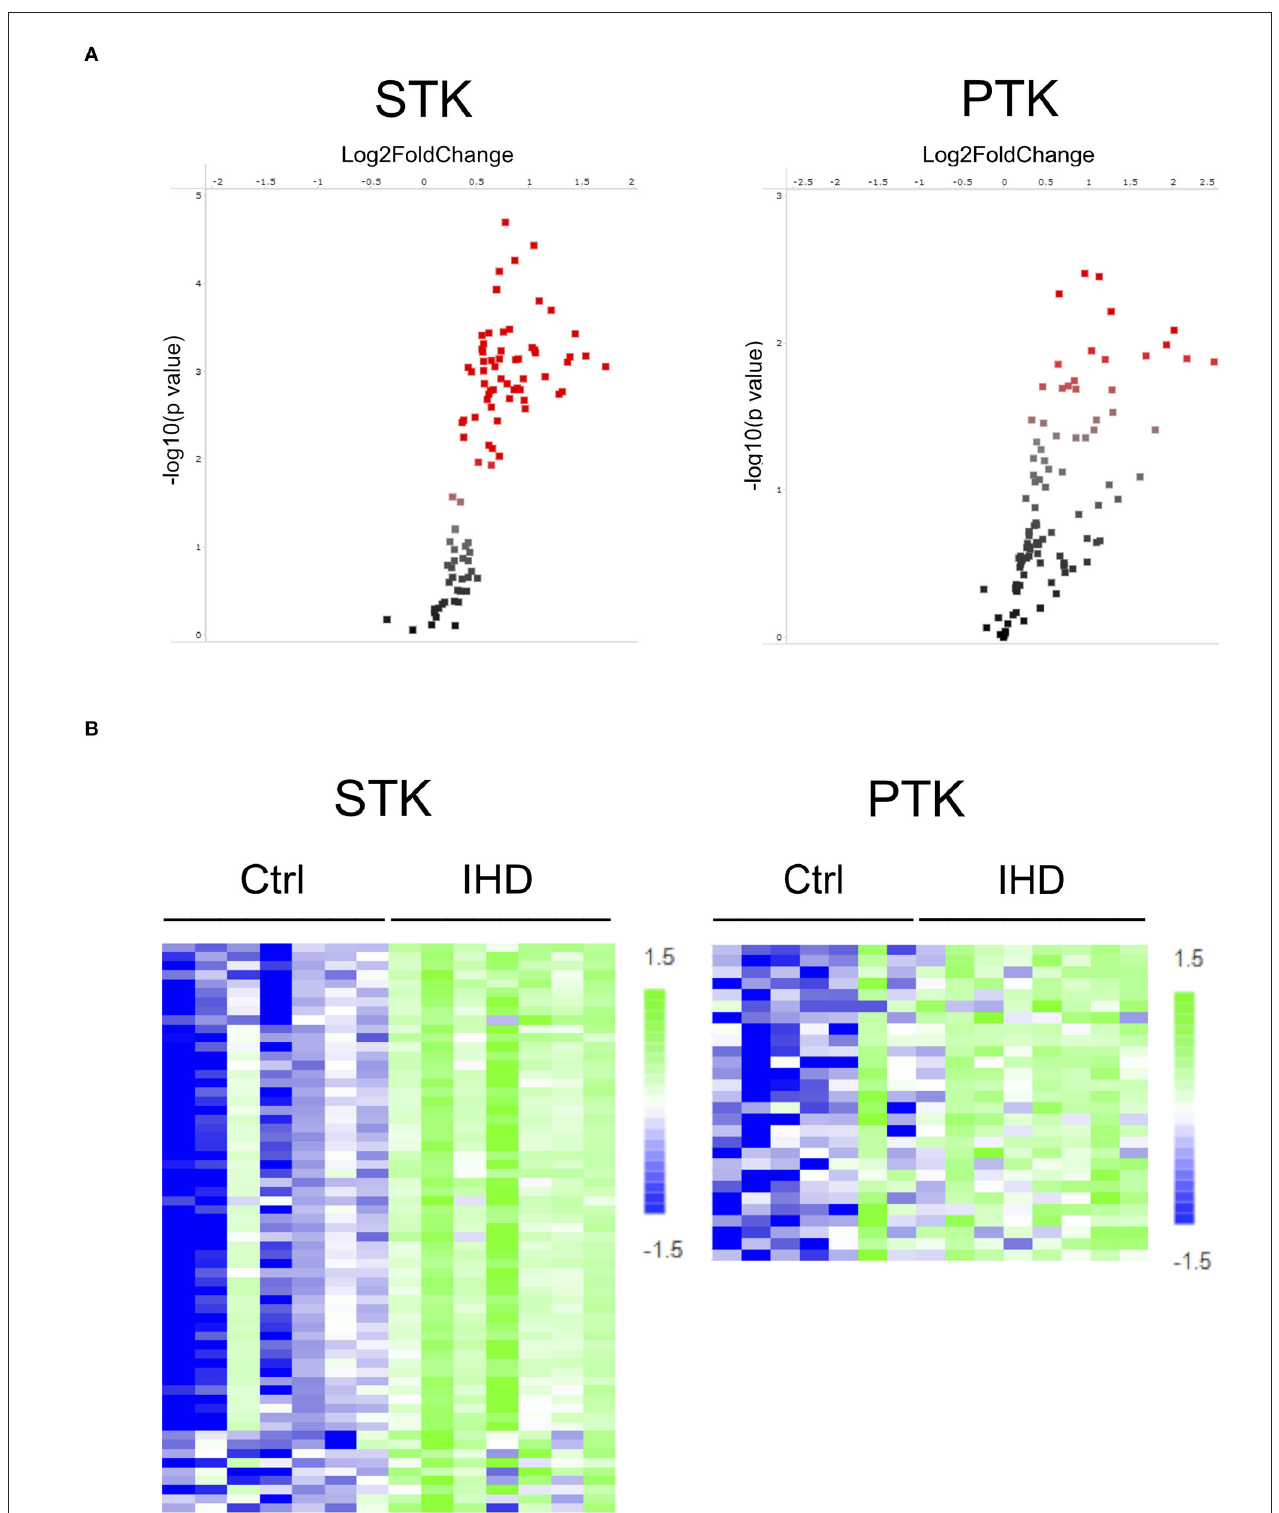
FIGURE 1 | Increased STK- and PTK-peptide phosphorylation in human IHD hearts. (A) Volcano plot. Red spots represent peptides having significant difference ( p < 0.05) between the IHD ( n = 8) and Ctrl ( n = 8) groups. (B) Scaled heatmap. The increase in phosphorylation of STK- and PTK-peptides was presented by the color change from dark blue in the controls to light green in the IHD patients. The detailed peptide sequences contributing most to the significant changes between the groups are shown in Supplementary Table 2 .